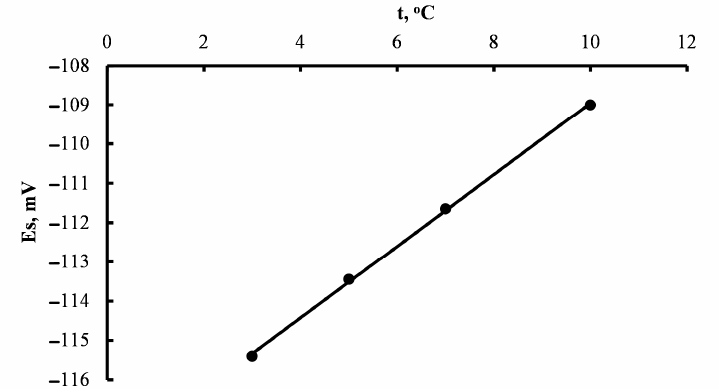
Figure 3. The temperature dependence of cell (A) in the TRIS-TRISHCl-NaCl-H 2 O buffer solution ( m NaCl = 0.4; m TRIS = m TRISHCl = 0.04). Station CR14 (39 ◦ 32.316 (cid:48) N; 136 ◦ 40.416 (cid:48) E), KH-10-02, 17 June 2010, JES. ( E s ) /mV = − 118.07 + 0.9112 · t; r 2 = t